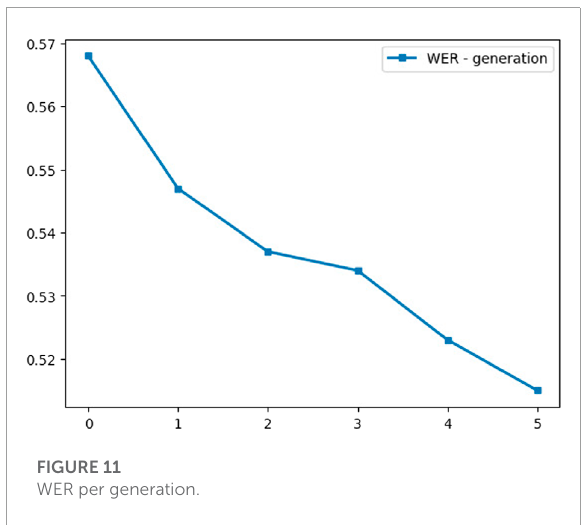
FIGURE 11 WER per generation.